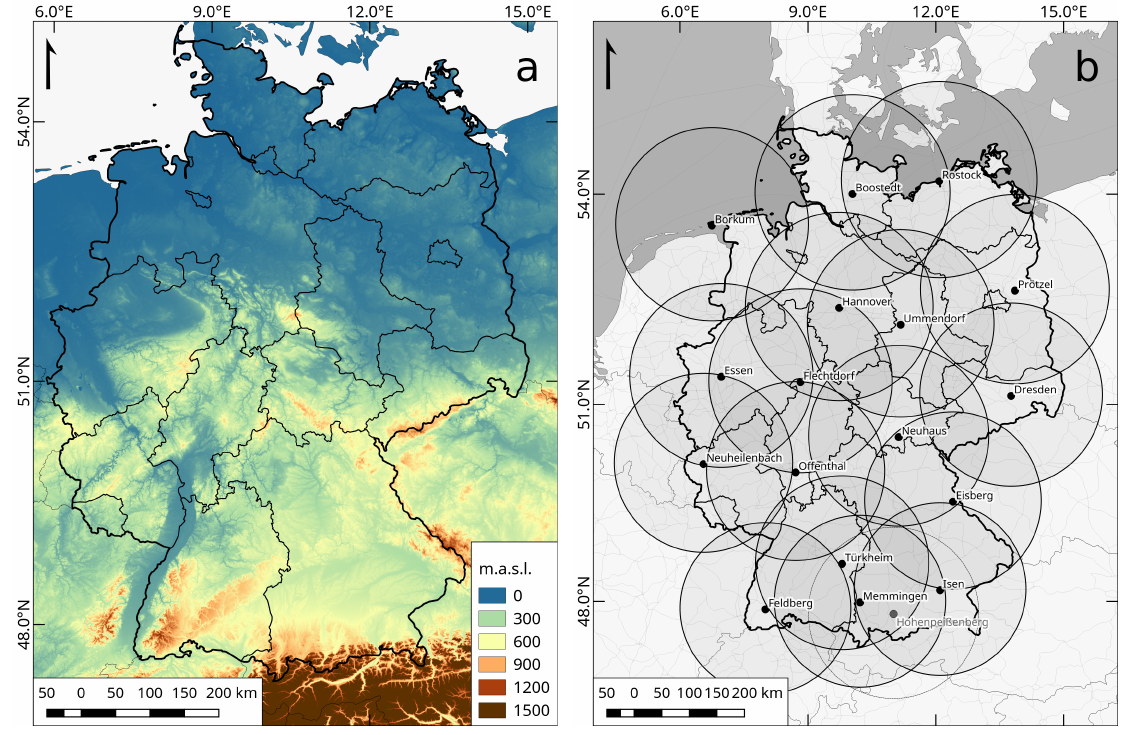
Figure 1. Digital elevation model of Germany based on SRTM 1 arc second data ( a ) and the observational network of weather radar stations contributing to the RADOLAN dataset ( b